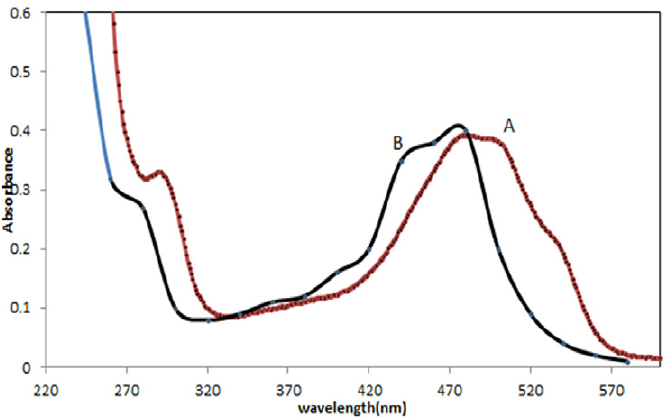
Fig. 5 UV-Vis spectra ofa)DAN and b)DAN- loaded nanocarrier Fig. 5. UV-Vis spectra ofa)DAN and b)DAN- loaded